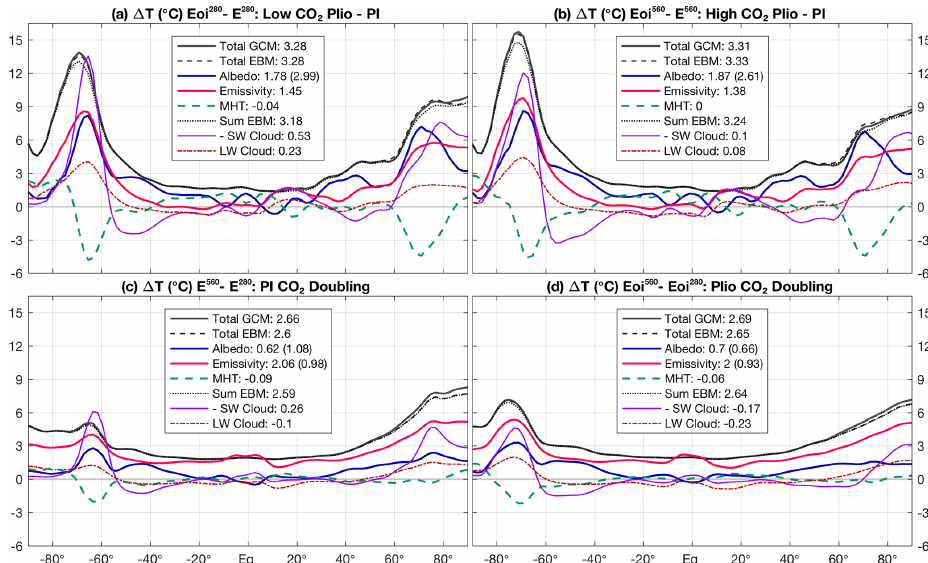
Figure 11. The same as in Fig. 10 but showing zonally averaged temperature differences and contributions from different components within the energy balance model (EBM). The temperature difference between our simulations (total GCM; solid grey) is compared to the one predicted by the EBM (total EBM; dashed dark grey). Components of the EBM include: planetary albedo (solid blue), emissivity (solid red), meridional heat transport (MHT, dashed green), shortwave cloud forcing (negative, solid purple) and longwave (dashed dark red) cloud forcing. The sum of the contributions from albedo, emissivity, and MHT is also shown (Sum EBM; dashed black). Globally averaged values are shown for each component, with bracketed values added for surface albedo and emissivity excluding the effect of CO 2